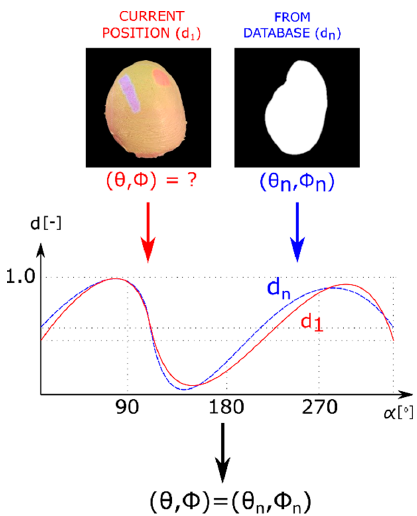
Figure 5. MARVIS system setup from a perspective view ( A ) and from its left side ( B ). HdTC 1 and HdTC 2 are the head-tracking cameras, and PhTC is the phantom-tracking camera.